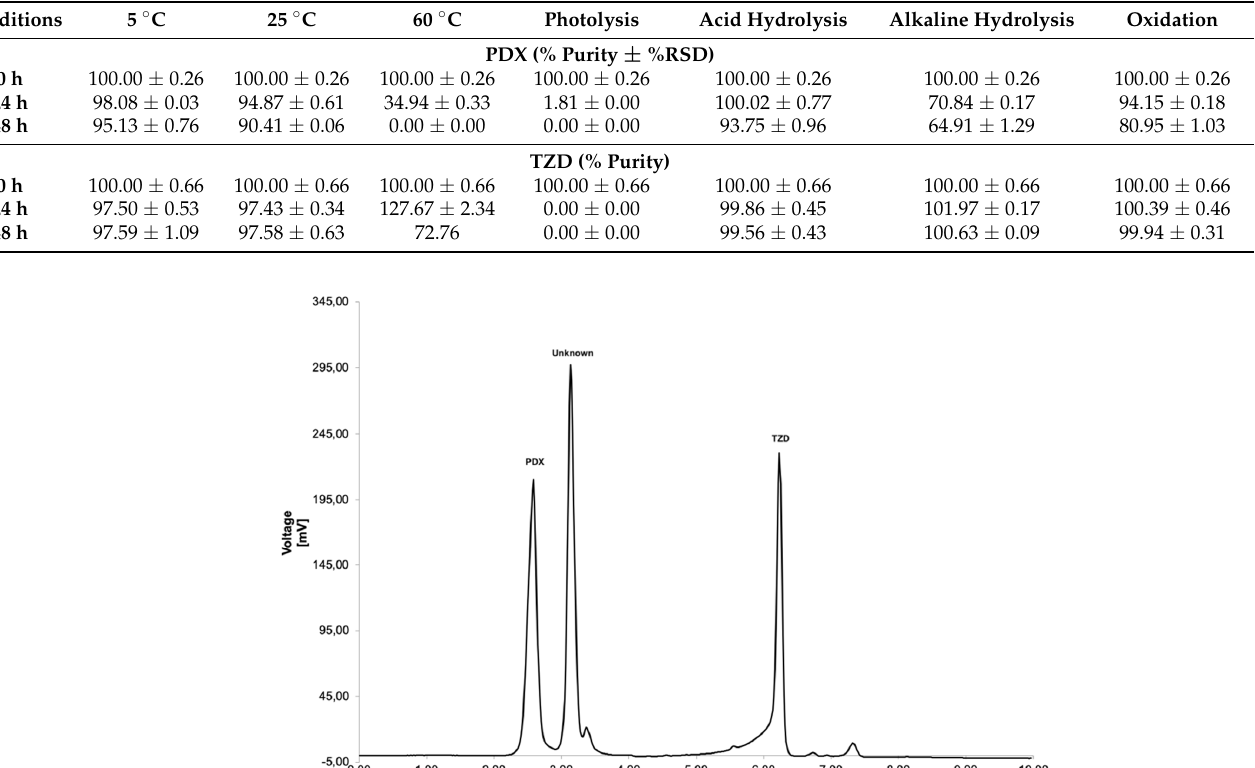
Figure 5. Chromatogram obtained with a solution containing 200 μ g/mL of both PDX and TZD after exposure to direct sunlight for a period of 24 h. Table 6. Percentage purity (%) calculated for PDX and TZD during exposure to various storage conditions as well as harsh environments for a period of three days. Conditions